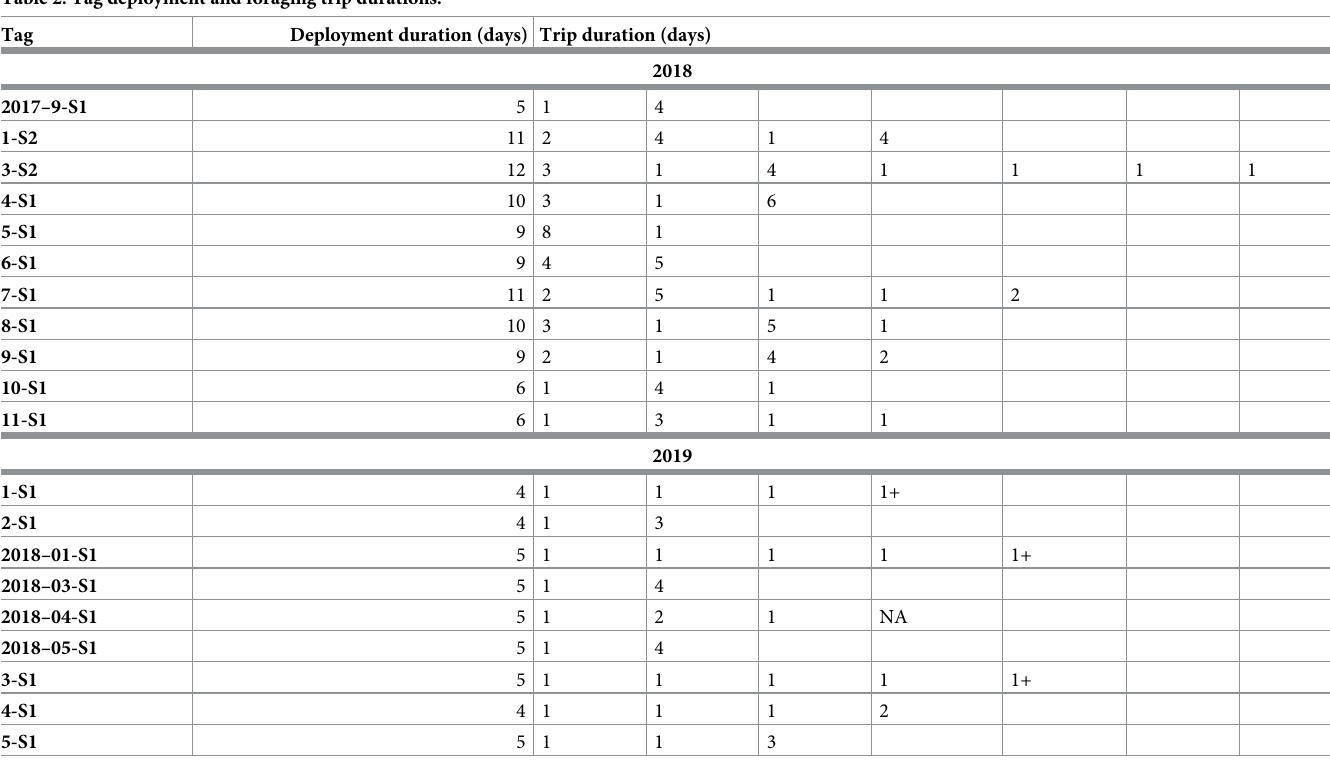
Table 2. Tag deployment and foraging trip durations.